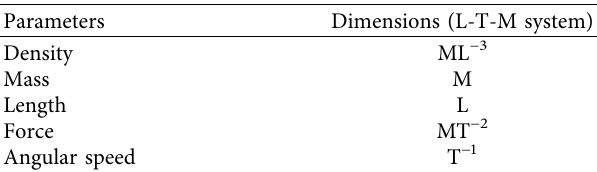
Figure 10: Structure of experiment apparatus of drillstring constrained in a horizontal pipe: (1) loading system; (2) pipe system; (3) circulatory system; (4) driving system; (5) testing system. Table 1: The dimensions of the parameters. Table